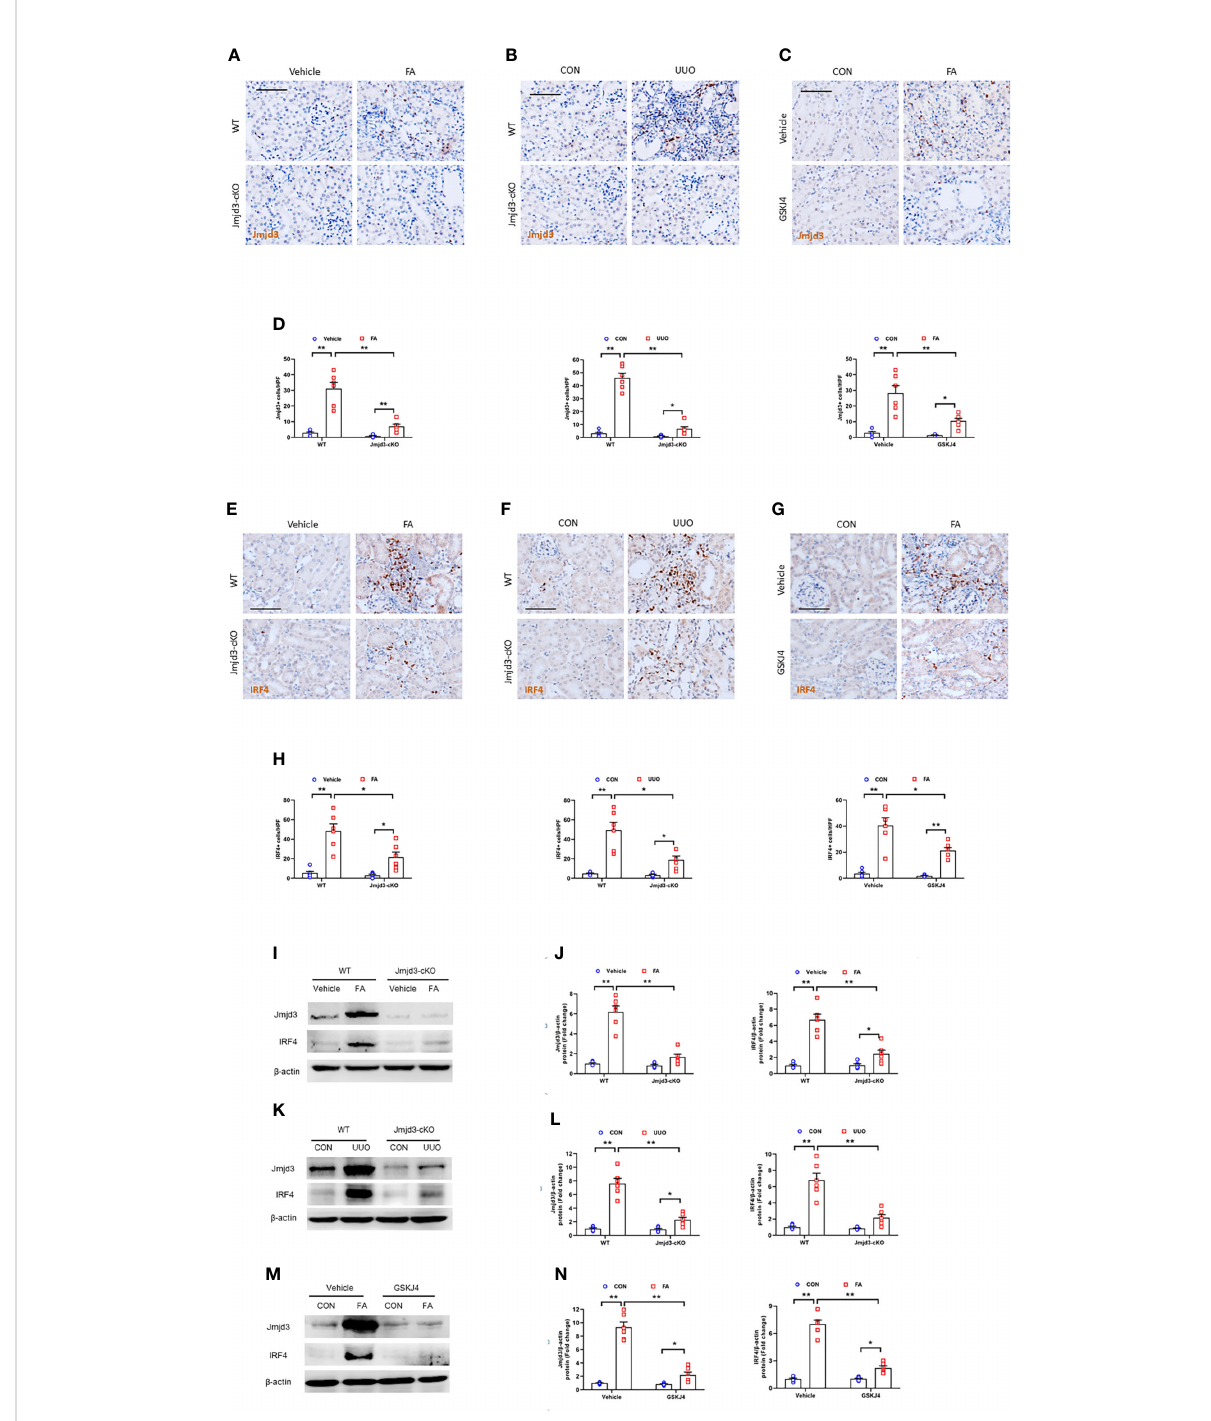
FIGURE 1 Jmjd3/IRF4 axis is highly activated in kidneys with FA or obstructive injury. (A – C) Kidney sections stained for Jmjd3 (brown) at day 14 after FA or UUO treatment. (D) Quantitative analysis of Jmjd3 + cells. (E – G) Representative photomicrographs of kidney sections stained for IRF4 (brown) at day 14 after FA or UUO treatment. (H) Quantitative analysis of IRF4 + cells. (I) Western blot bands of Jmjd3 and IRF4 in kidneys with or without FA injury. (J) Quantitative analysis of Jmjd3 and IRF4 protein levels with or without FA injury. (K) Western blot bands of Jmjd3 and IRF4 in the kidneys with or without UUO injury. (L) Quantitative analysis of Jmjd3 and IRF4 protein levels in the kidneys o with or without UUO injury. (M) Western blot bands of Jmjd3 and IRF4 in control or FA-injured kidneys with or without GSKJ4 treatment. (N) Quantitative analysis of Jmjd3 and IRF4 protein levels in control or FA- injured kidneys of mice with or without GSKJ4 treatment. * P <0.05 or ** P <0.01; n=6; Bar = 50 m m. WT, wild-type; cKO, conditional knockout; HPF, high-power fi